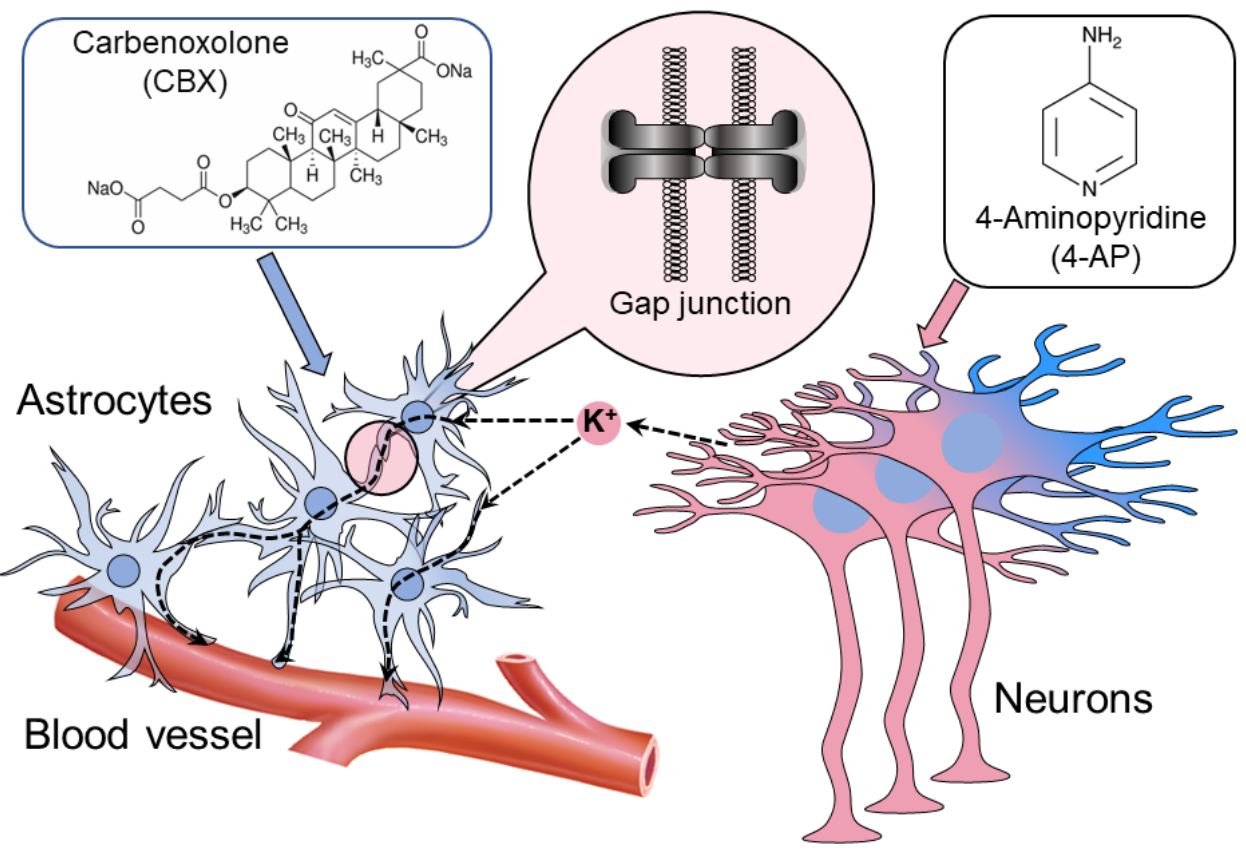
Figure 4. Movement of K + (dotted arrows) in the astrocytic syncytium and their interaction with neural circuits. Gap junctions play a crucial role in the dispersal of K + and its buffering by astrocytes. The astrocytic syncytium evens out the concentration of extracellular K + , absorbing it in areas of increased concentration and secreting it in areas of low concentration. Individual astrocytes reduce the concentration of K + by absorbing it through the Kir1.4 channel, and excess K + is released into the bloodstream. Intracortically injected 4-AP acts on neurons, causing synchronized epileptiform activity.